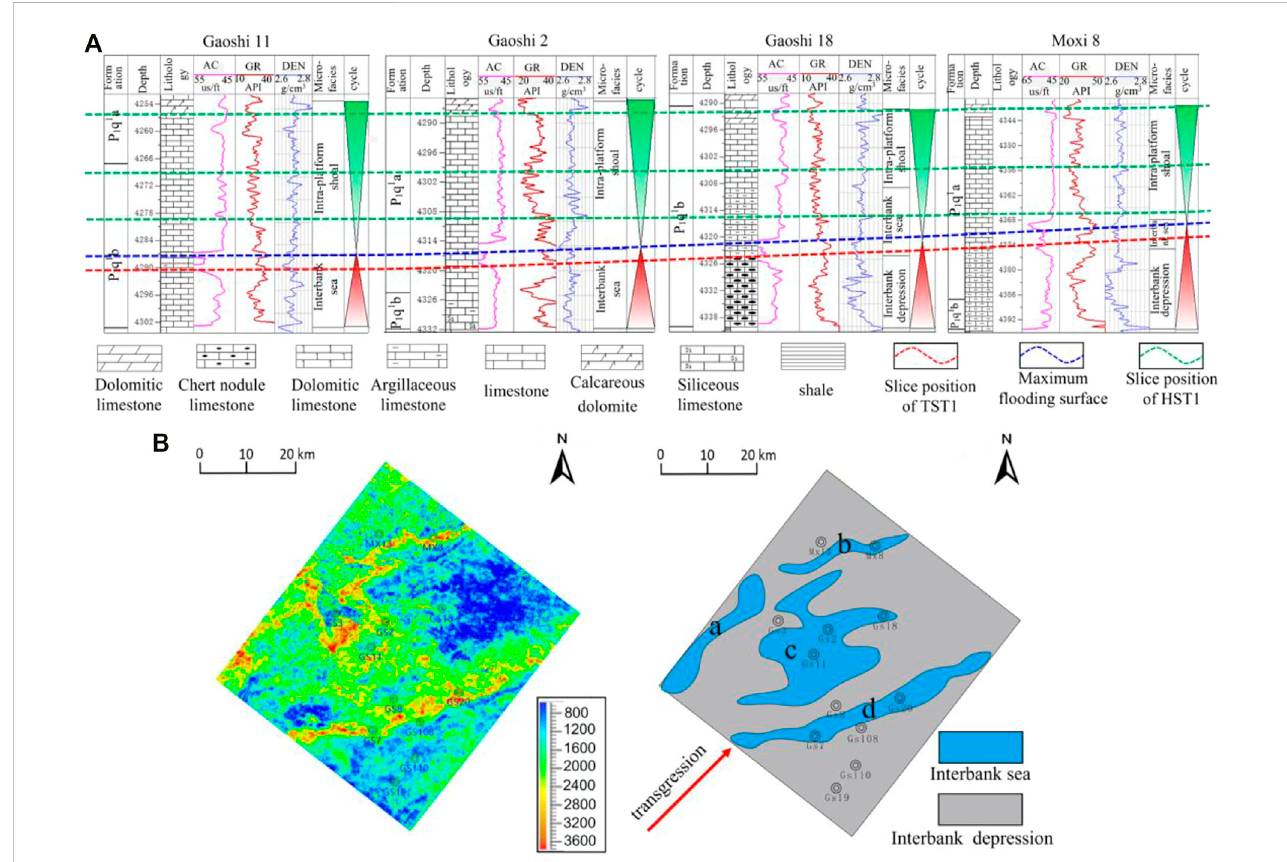
FIGURE 11 (A) log curve and sedimentary microfacies interpretation diagram of representative well location in SQ1 period; (B) Typical root mean square amplitude attribute slice and corresponding sedimentary microfacies interpretation during